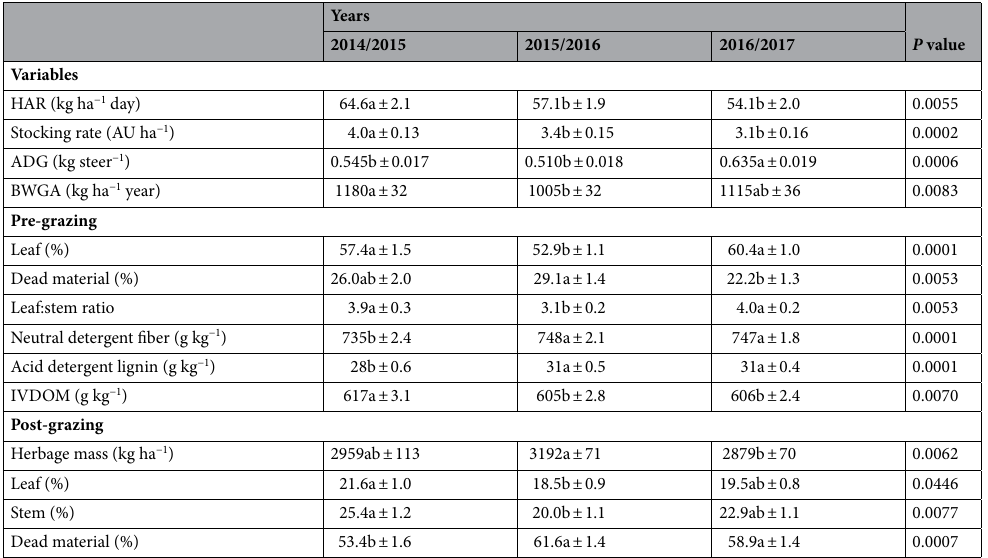
Table 5. Average and standard error of mean (±) and probability level ( p ) for herbage accumulation rate (HAR), stocking rate, average daily gain (ADG), body weight gain per area (BWGA), pre-grazing leaf and dead material percentages, leaf:stem ratio, neutral detergent fiber and acid detergent lignin concentrations, in vitro digestible organic matter (IVDOM) percentage of leaves, post-grazing herbage mass, leaf, stem and dead material percentages for P. maximum cv. Mombaça guinea grass pastures subjected to rotational stocking and fertilized with three nitrogen levels, in the experimental years. Values followed by different letters in row, were significantly different according to the Tukey test at P <